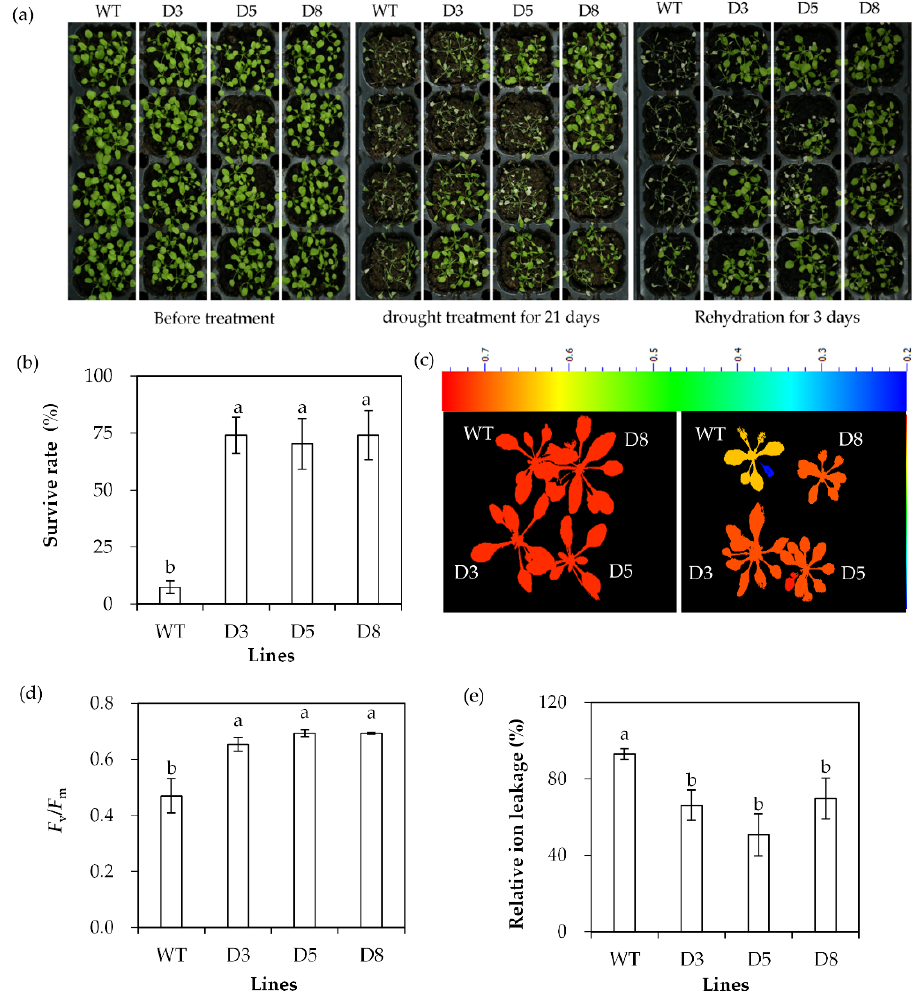
Figure 6. Analysis of drought tolerance in transgenic plants in comparison with the wild type (WT). Two-week-old seedlings were withheld from irrigation for drought treatment. Photos were taken at the time points as indicated in the figure ( a ). Survival rate was determined after 21 days of drought, followed by 3 days of rewatering ( b ). F v / F m ( c , d ) and relative ion leakage ( e ) were determined after 14 days of drought. Means of three replicates and standard errors are presented; the same letter above the column indicates no significant difference at p < 0.05.